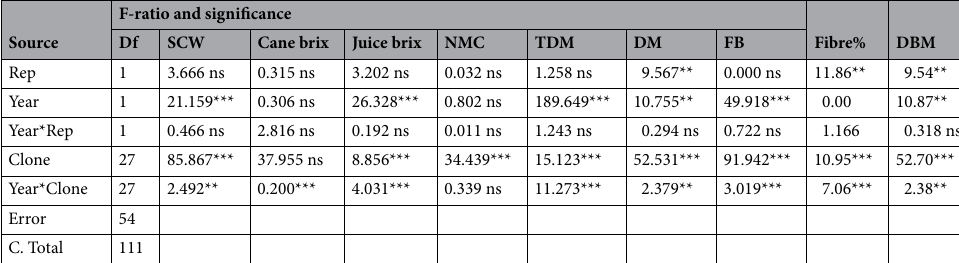
Table 2. Results of the two-way analysis (F-ratio) showing the effects of genotypes and year on the different traits of sugarcane clones (SCW: single cane weight, NMC: number of millable canes, TDM: total dry matter, DM: dry matter, FB: fresh biomass). Level of significance: ***, **, * and ns indicate significance at P < 0.001, P < 0.01, P < 0.05, and non-significance,